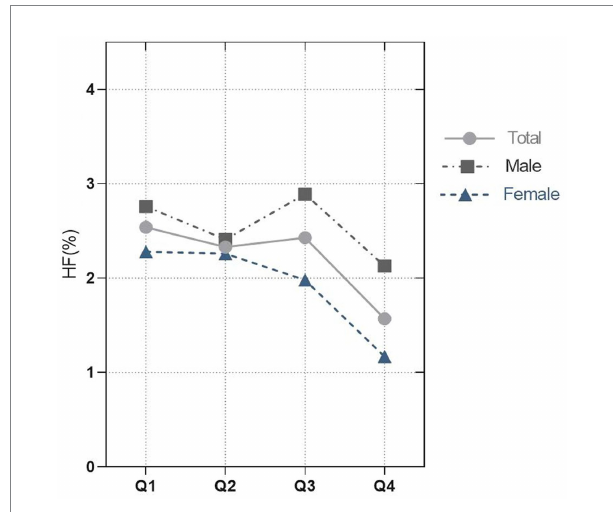
FIGURE 2 Proportion of heart failure in the quartile of anthocyanidins.